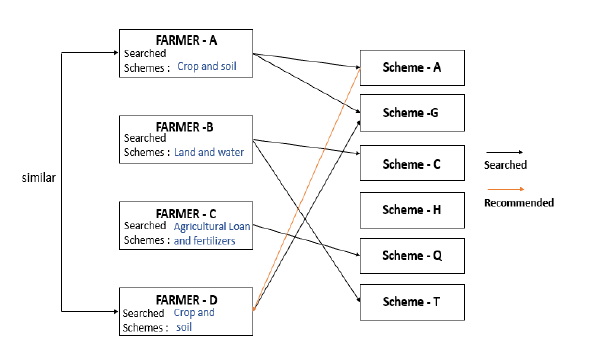
Figure 6. Collaborative Filtering Diagram